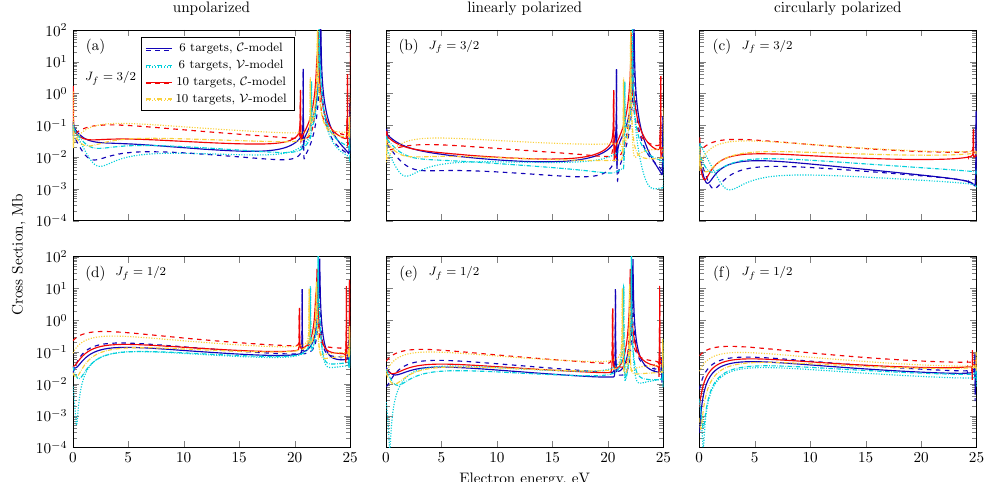
Figure 4. Cross-section calculated within the V - (dash-dotted lines correspond to length gauge, dotted lines to velocity gauge) and C - (solid lines correspond to length gauge, dashed lines to velocity gauge) models with six (cyan and blue) and ten (orange and red) target states for ionization of 2 s 2 2 p 5 ( 2 P 1/2 ) 3 s [ 1/2 ] 1 state to 2 s 2 2 p 5 ( 2 P 3/2 ) (upper row) and 2 s 2 2 p 5 ( 2 P 1/2 ) (bottom row) ionic states for unpolarized ( a , d ), linearly polarized ( b , e ) and circularly polarized ( c , f ) fields. Within the V -model, orange and cyan lines in panels ( d , e , f ) practically